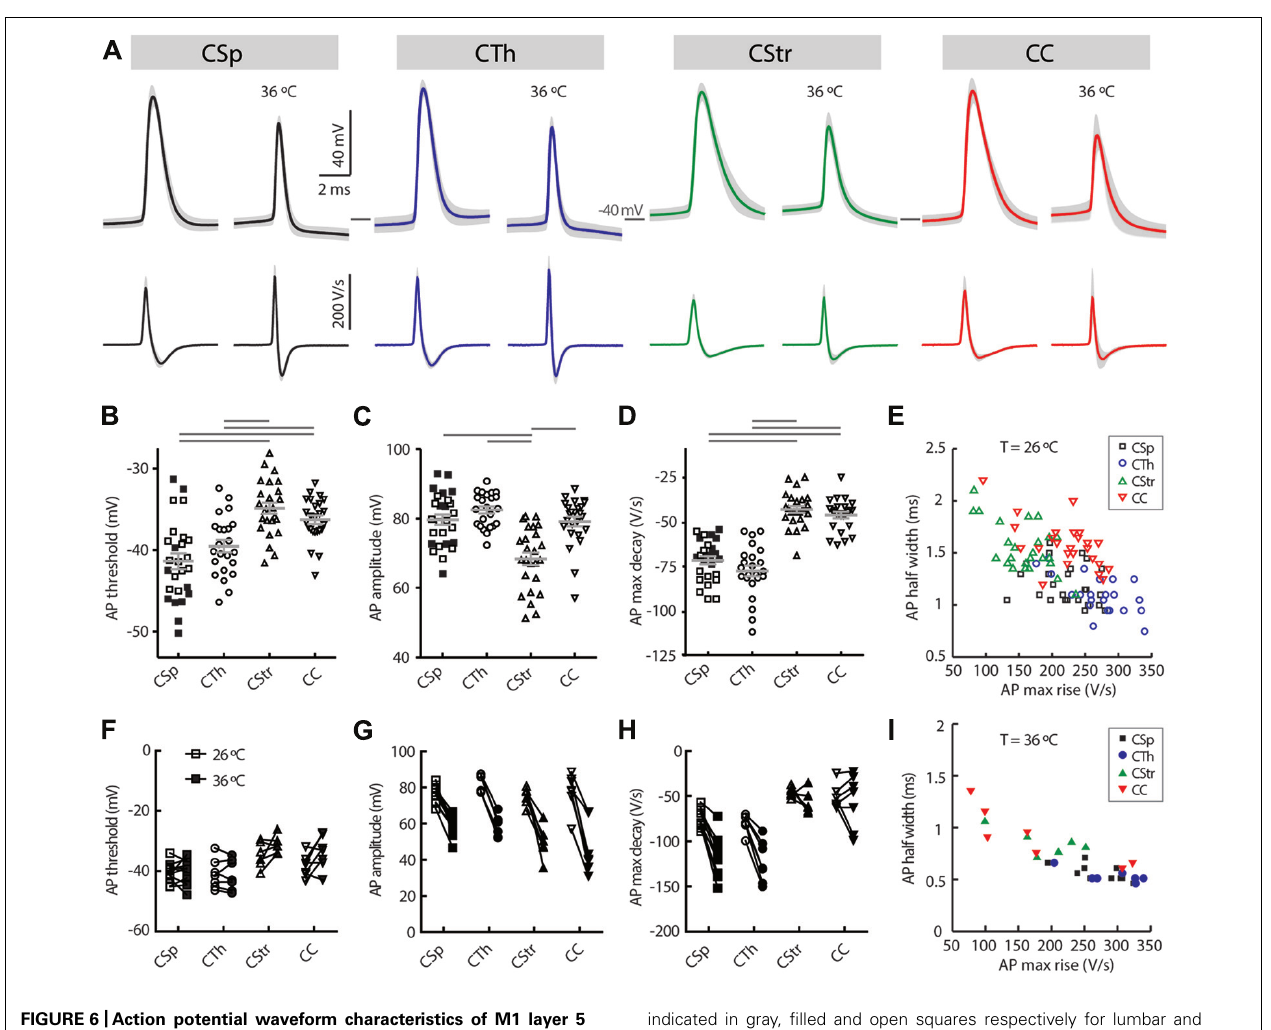
FIGURE 6 |Action potential waveform characteristics of M1 layer 5 neurons grouped by projection target. (A) Average action potential waveforms (upper panel) and first derivatives of the waveform (lower panel) in the same neurons at 26 ◦ C (left) and 36 ◦ C (right; n = 10 CSp, 7 CTh, 7 CStr, and 7 CC neurons; a single AP was evoked in each neuron by a near threshold current ramp; SDs are indicated by gray shading). Distribution of the action potential threshold (B) , amplitude (C) and maximum decay (D) in the different groups at 26 ◦ C (means ± SEM